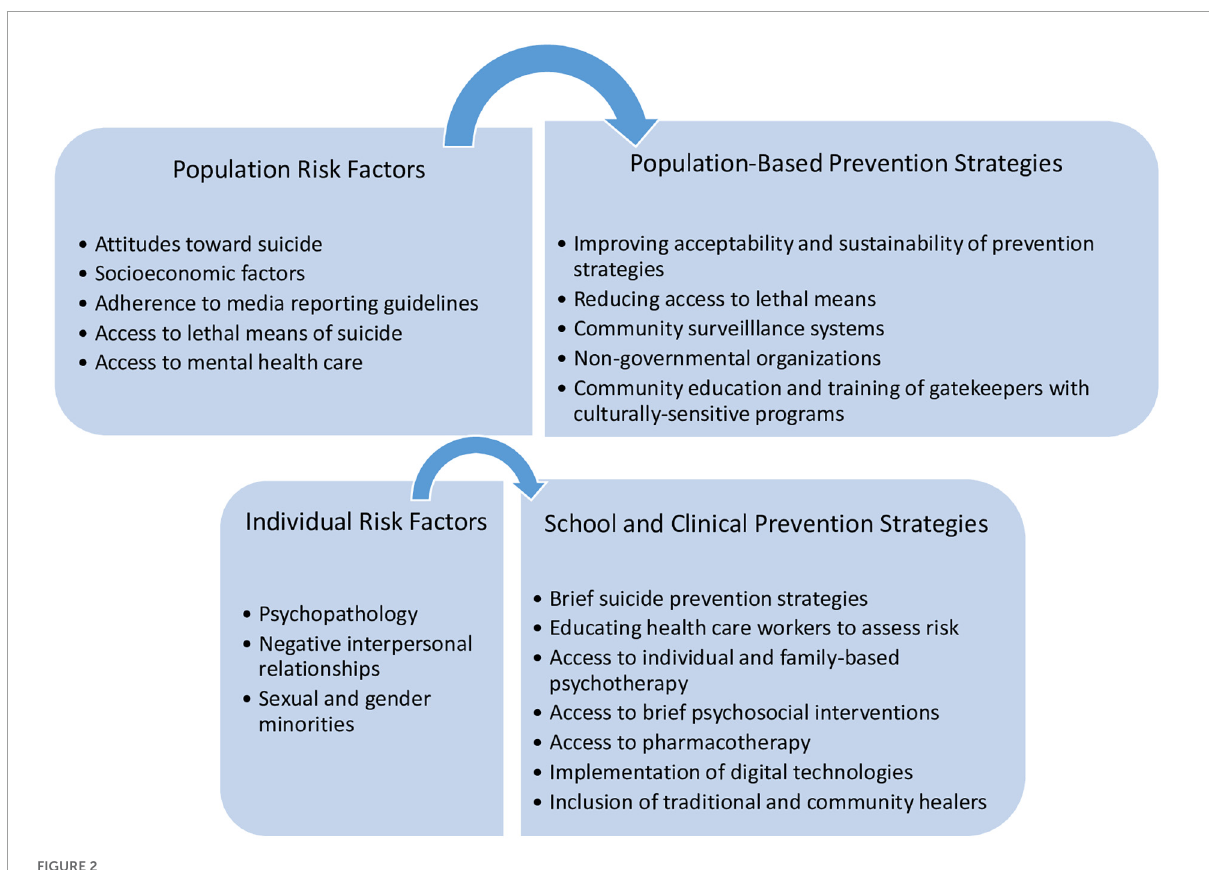
FIGURE2 Youth-specific suicide risk factors and related prevention